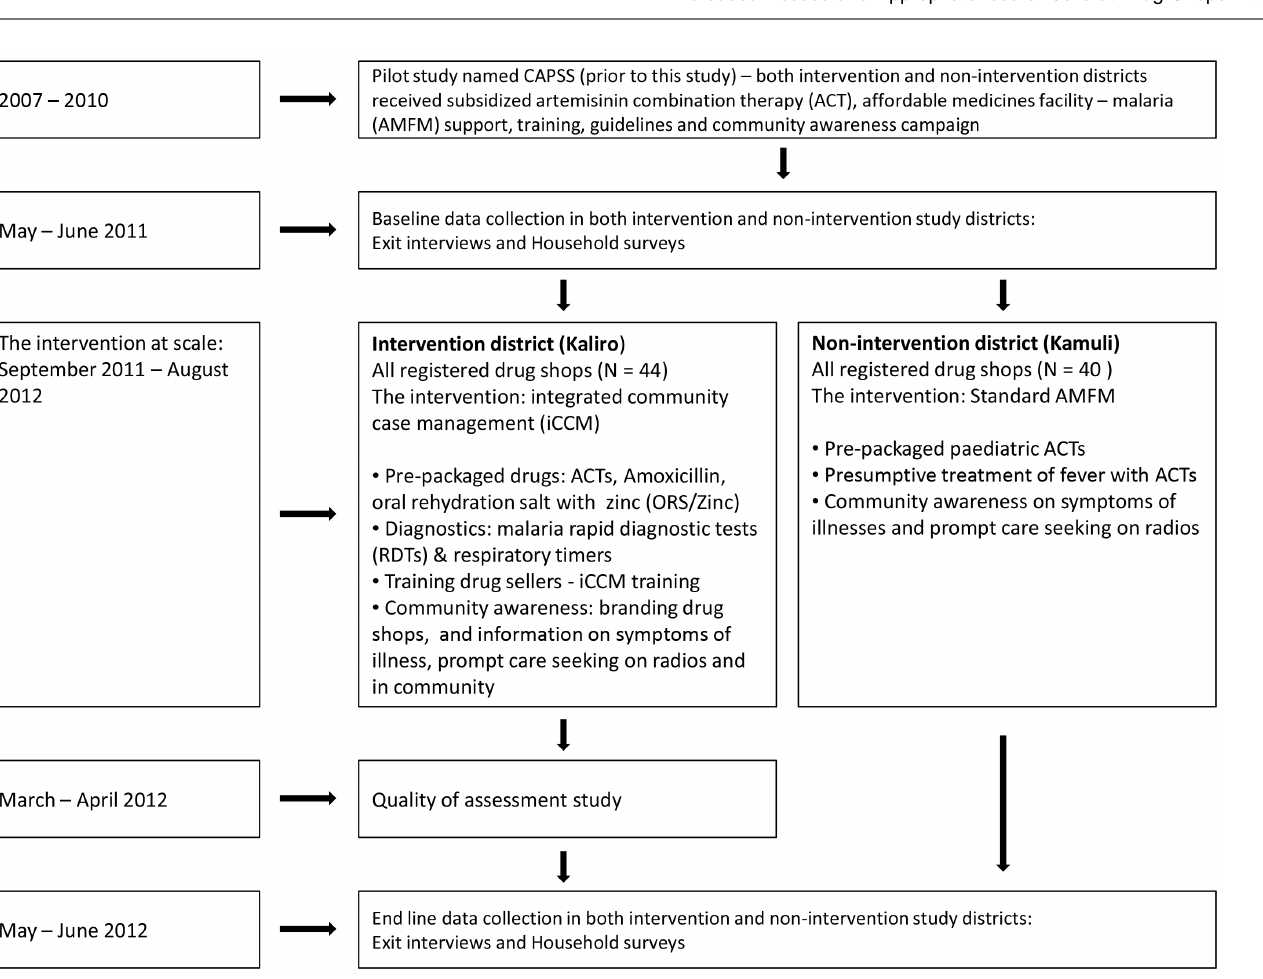
Fig. 1. Study design and timing of interventions and data